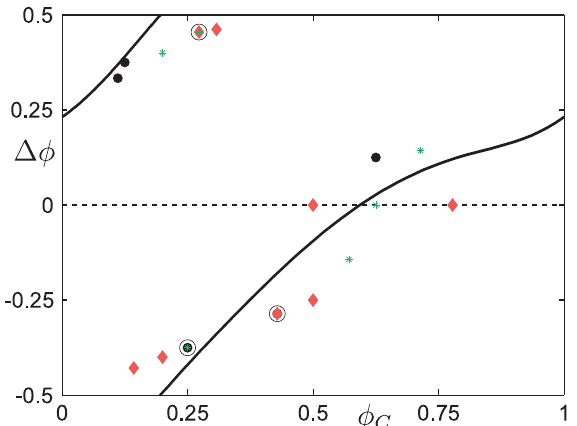
Figure 7. Comparison of theoretical PRC with experimental data confirms a Type 0 phase resetting mechanism. The Type 0 phase response curve for L ~ 6 : 8 as computed with the model (black curve). The experimental data, plotted at discrete points, is shown for eight female Sprague-Dawley rats (red diamonds), five female Lewis rats (black dots), and six male PVG rats (green stars). Points where two samples take the same value are circled.